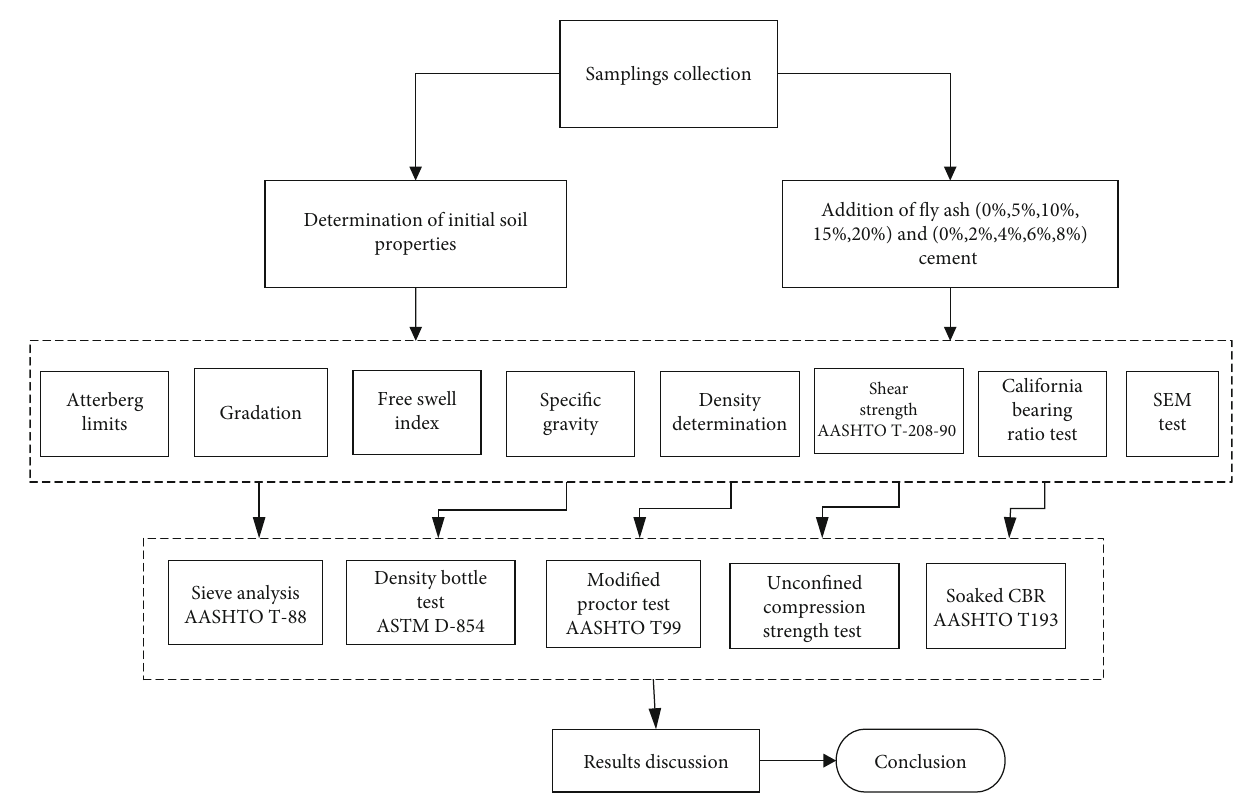
Figure 2: Subgrade soil tests with and without additives. Table 2: Properties of subgrade soil. Table 3: Atterberg limits in subgrade soil by adding fl y ash and